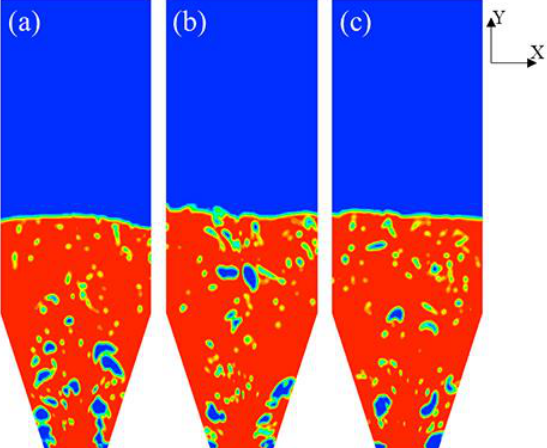
Figure 5. Distribution of bubbles at different liquid densities; ( a ) 1000 kg/m 3 , ( b ) 1261 kg/m 3 , ( c ) 1650 kg/m 3 .